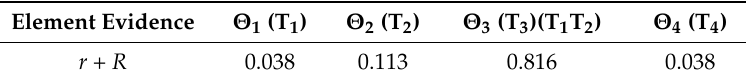
Table 8. Third fusion